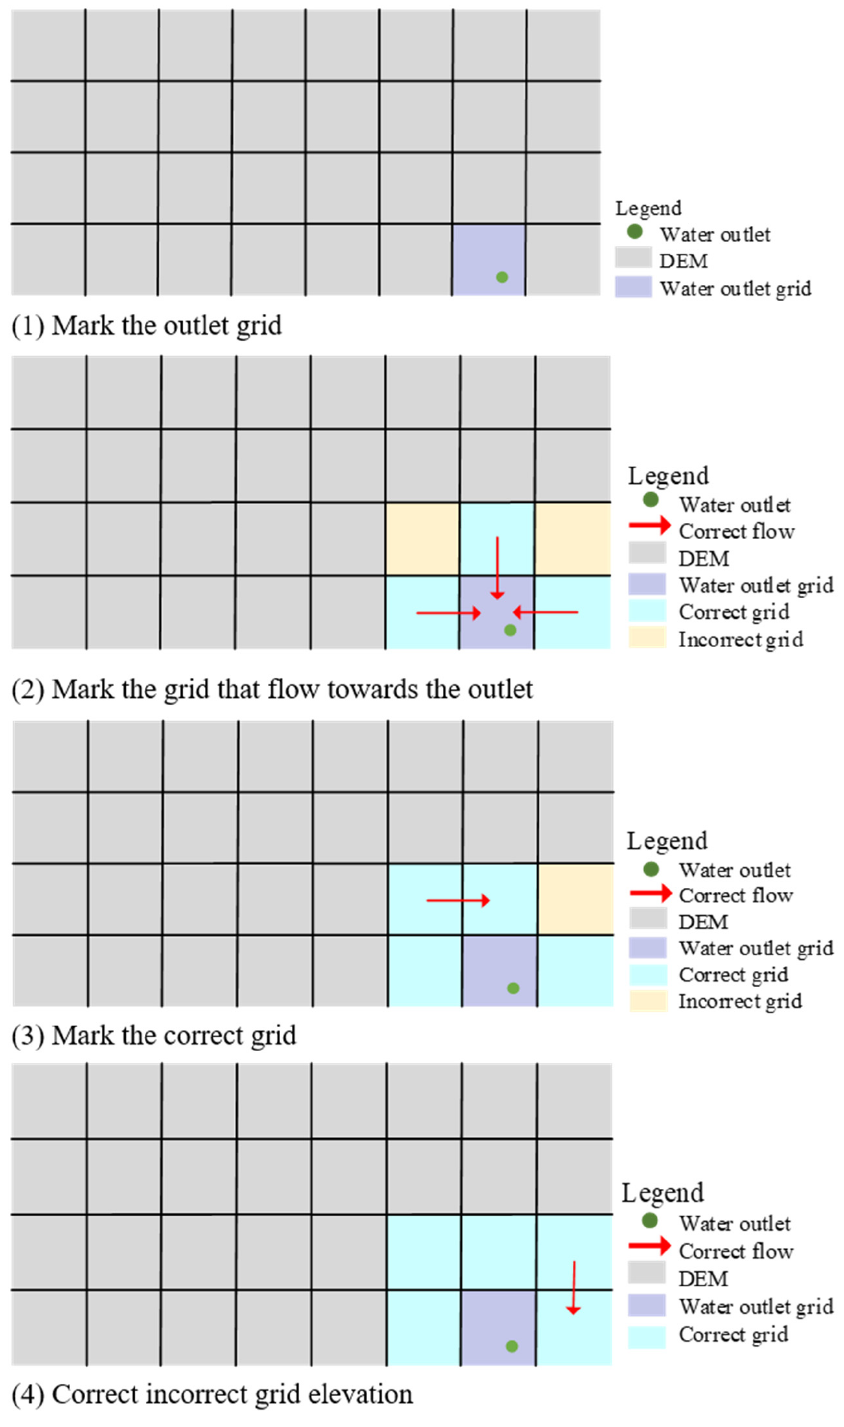
Figure 6. Road DEM correction process.